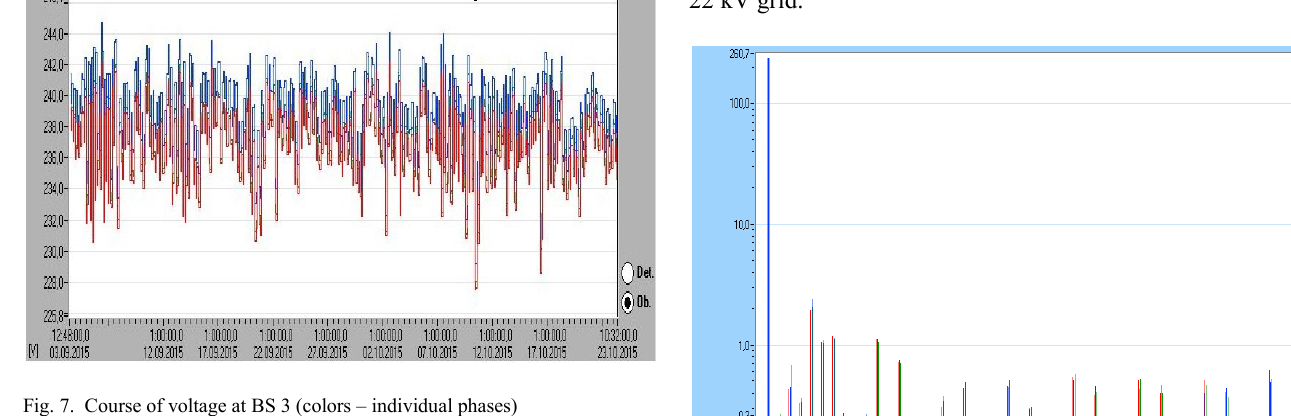
Fig. 7. Course of voltage at BS 3 (colors – individual phases)